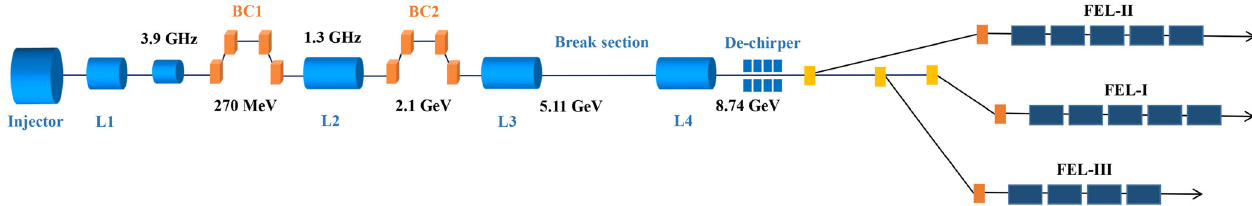
FIG. 1. Schematic layout of the